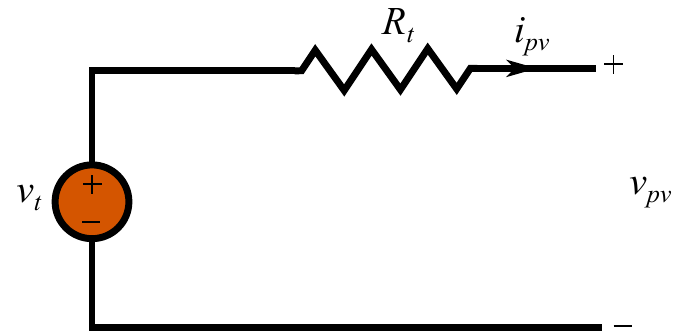
Figure 5. The simplified equivalent circuit of the PV source.